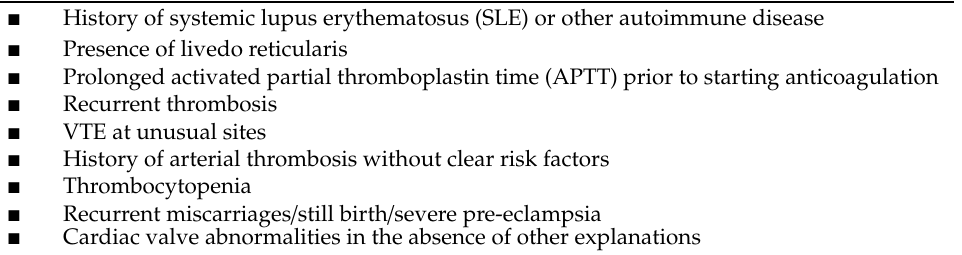
Table 1. When to order antiphospholipid antibodies (aPL) testing, Adapted from